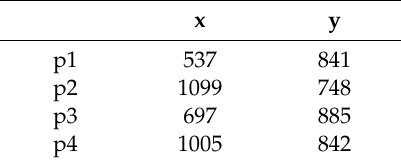
Figure 3. View from rear camera showing graph-paper lined channel marked with points 50 mm apart on the top edges. Spot where laser hits graph paper covering channel entrance shows that the vehicle is tilted toward the right-hand wall of the channel. Table 1. Coordinates of line end points in Figure 3.